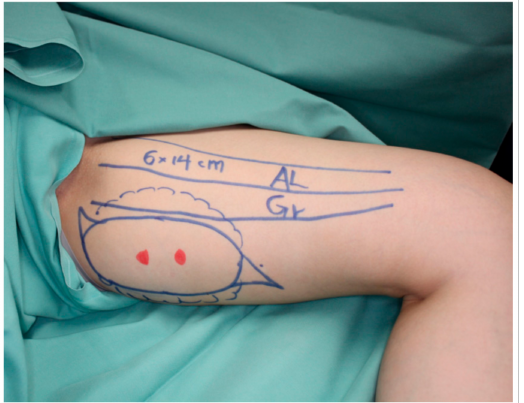
Figure 4. A vertical PAP flap with a skin paddle of 14 × 6 cm was harvested from the left medial thigh. The pedicle was anastomosed to the internal mammary vessels in an end-to-end fashion. The PAP flap was de-epithelialized and inset to fill the lower pole of the breast, and a skin island was left for postoperative monitoring. The pectoralis major muscle roll was elevated and sutured to the PAP flap (Figure 5).